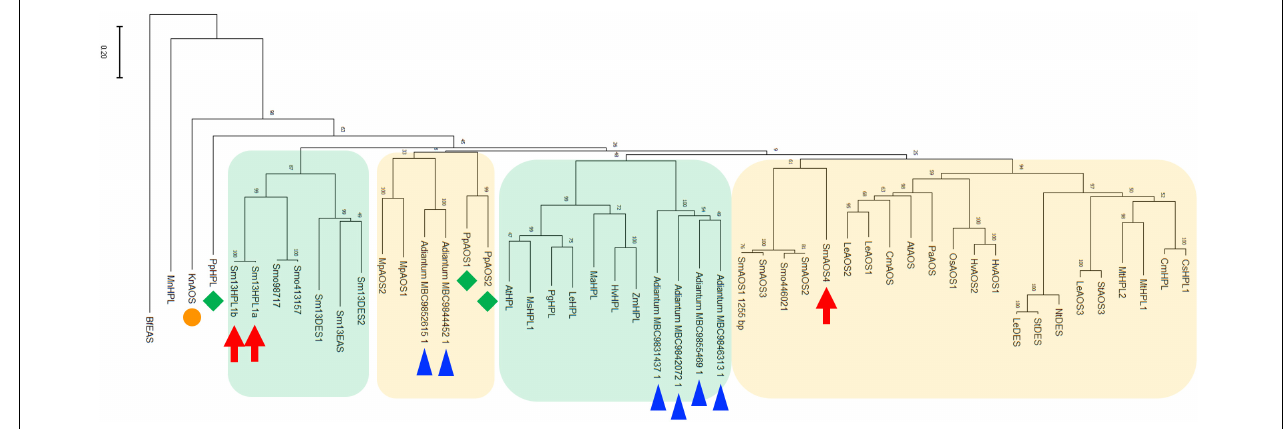
FIGURE 7 | Phylogenetic analysis of SmHPL1a and b and SmAOS4 with the CYP74 enzymes from different species. Phylogenetic analysis was performed in MEGAX using the maximum likelihood method. The details of the sequences used here are shown in Supplementary Table 3 . SmHPL1a/b and SmAOS4 are highlighted with red arrows. HPL and AOSs from P. patens are highlighted with green diamonds, and K. nitens AOS is with an orange circle. The genes found with transcriptome analyses on A. capillus-veneris are highlighted with blue triangles. The clade consisting of HPL, DES, and EAS from S. moellendorffii , and the one of seed plant HPLs are shown with green background, respectively. The clade mainly consisting of bryophyte AOSs, and the one of land plant AOSs, DESs, and 9/13HPLs are shown with orange background, respectively.